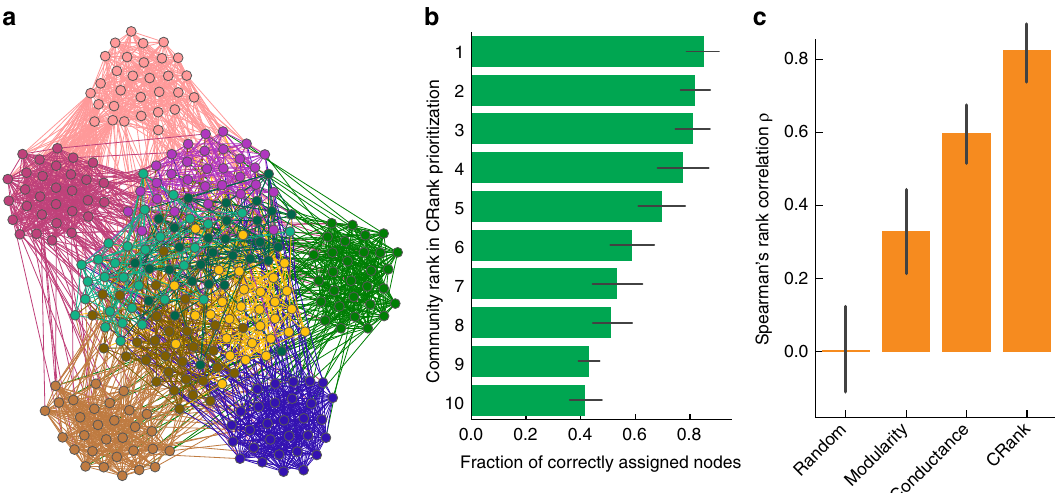
Fig. 2 Synthetic networks with planted community structure. a – c In networks with known modular structure we can evaluate community prioritization by quantifying the correspondence between detected communities and the planted communities. a Benchmark networks on N = 300 nodes are created using a stochastic block model with 10 planted communities 10 . Each planted community has 30 nodes, which are colored by their planted community assignment. Planted communities use different values for within-community edge probability p in , fi ve use p in = 0.6 and fi ve use p in = 0.2. As a result, planted communities with smaller within-community probability p in are harder to detect. For each benchmark network we apply a community detection method 6 to detect communities and then use CR ANK to prioritize them. CR ANK produces a ranked list of detected communities. The gold standard rank of each community is determined by how accurately it corresponds to its planted counterpart. b Each bar represents one detected community and the bars are ordered by CR ANK ’ s ranking with the highest-ranked community located at the top and the lowest ranked community located at the bottom. As a form of validation, the width of each bar corresponds to the fraction of nodes in a community that are correctly classi fi ed into a corresponding planted community, with error bars showing the 95% con fi dence intervals over 500 benchmark networks. A perfect prioritization ranks the bars by decreasing width. Notice that CR ANK perfectly prioritizes the communities even though it only uses information about the network structure, and has no access to information about the planted communities. c Prioritization performance is measured using Spearman ’ s rank correlation ρ between the generated ranking and the gold standard ranking of communities. A larger value of ρ indicates a better performance. Across all benchmark networks, CR ANK achieved average Spearman ’ s rank correlation of ρ = 0.82. Alternative approaches resulted in poorer average performance: ranking based on modularity and conductance achieved ρ = 0.33 and ρ = 0.60, respectively, whereas random prioritization obtained ρ =